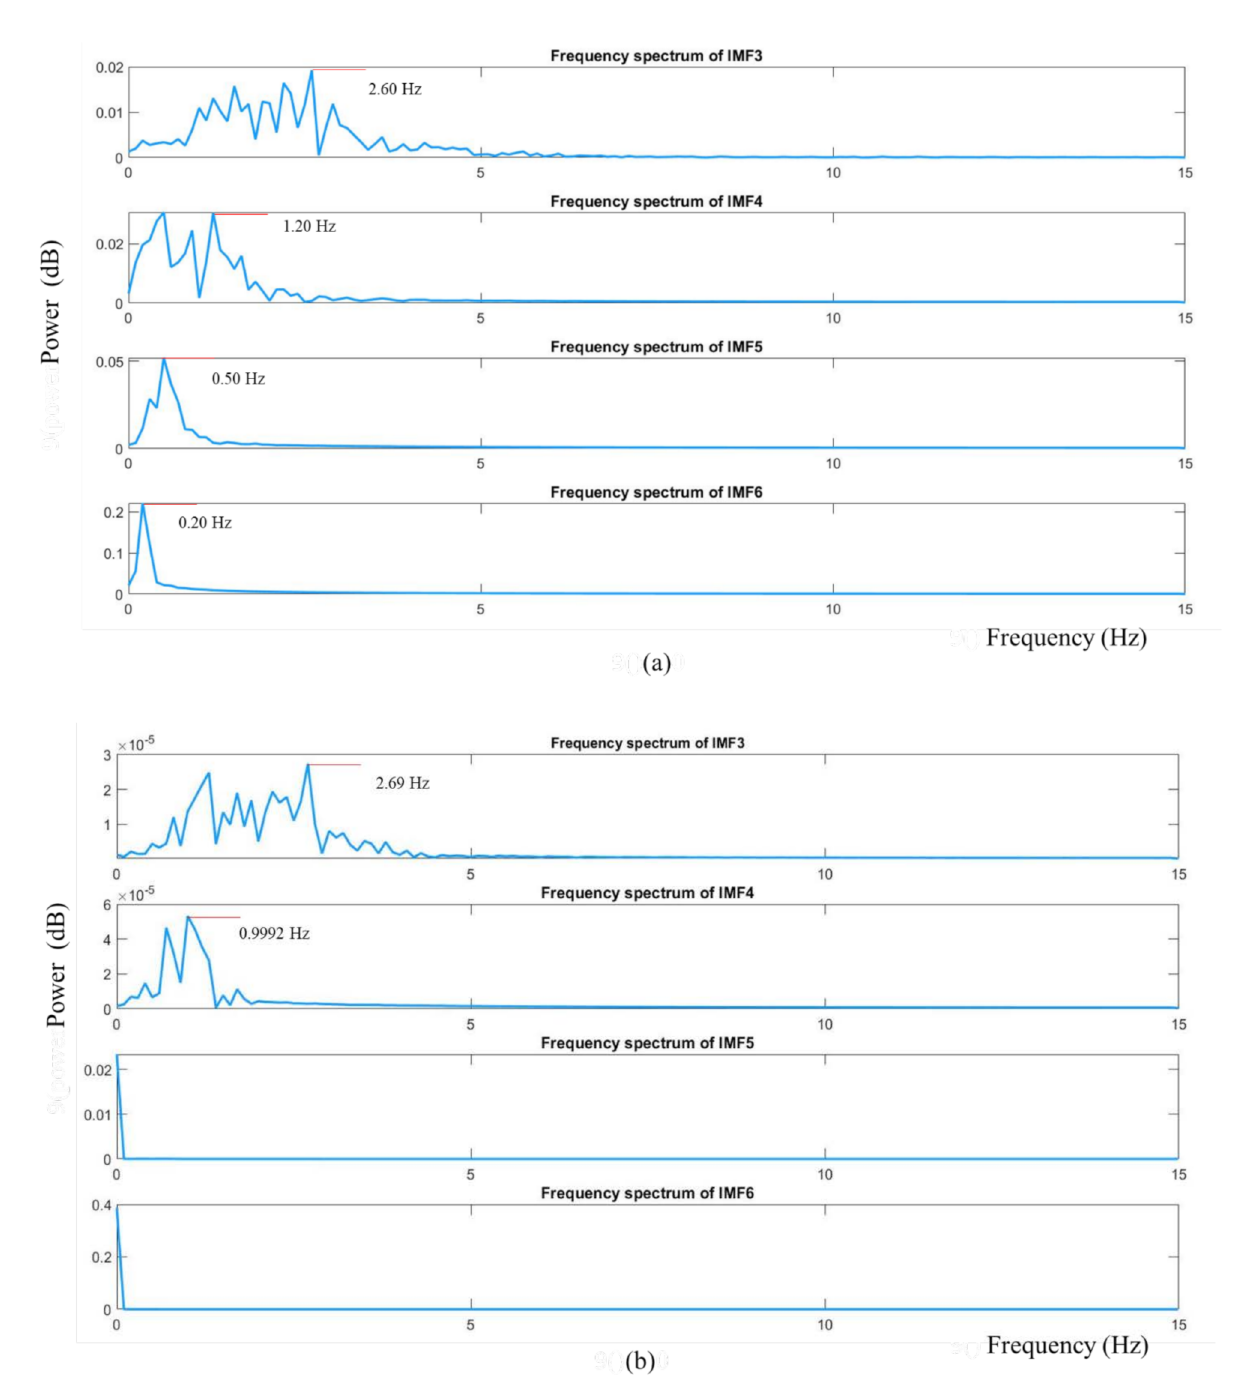
Figure 9. The frequency spectrum of decomposed IMF3, IMF4, IMF5 and IMF6. ( a ) Cardiac signal ( b ) respiratory signal. Figure 10a demonstrates the filtered cardiac signal achieved after FFT, band-pass filtering and inverse FFT. The window length of the FFT was 10 s. From the filtered signal, we calculated the HR by calculating the number of peaks. Similarly, Figure 10b presents the filtered respiratory signal. By calculating the number of peaks, RR could also be calculated from the filtered respiratory